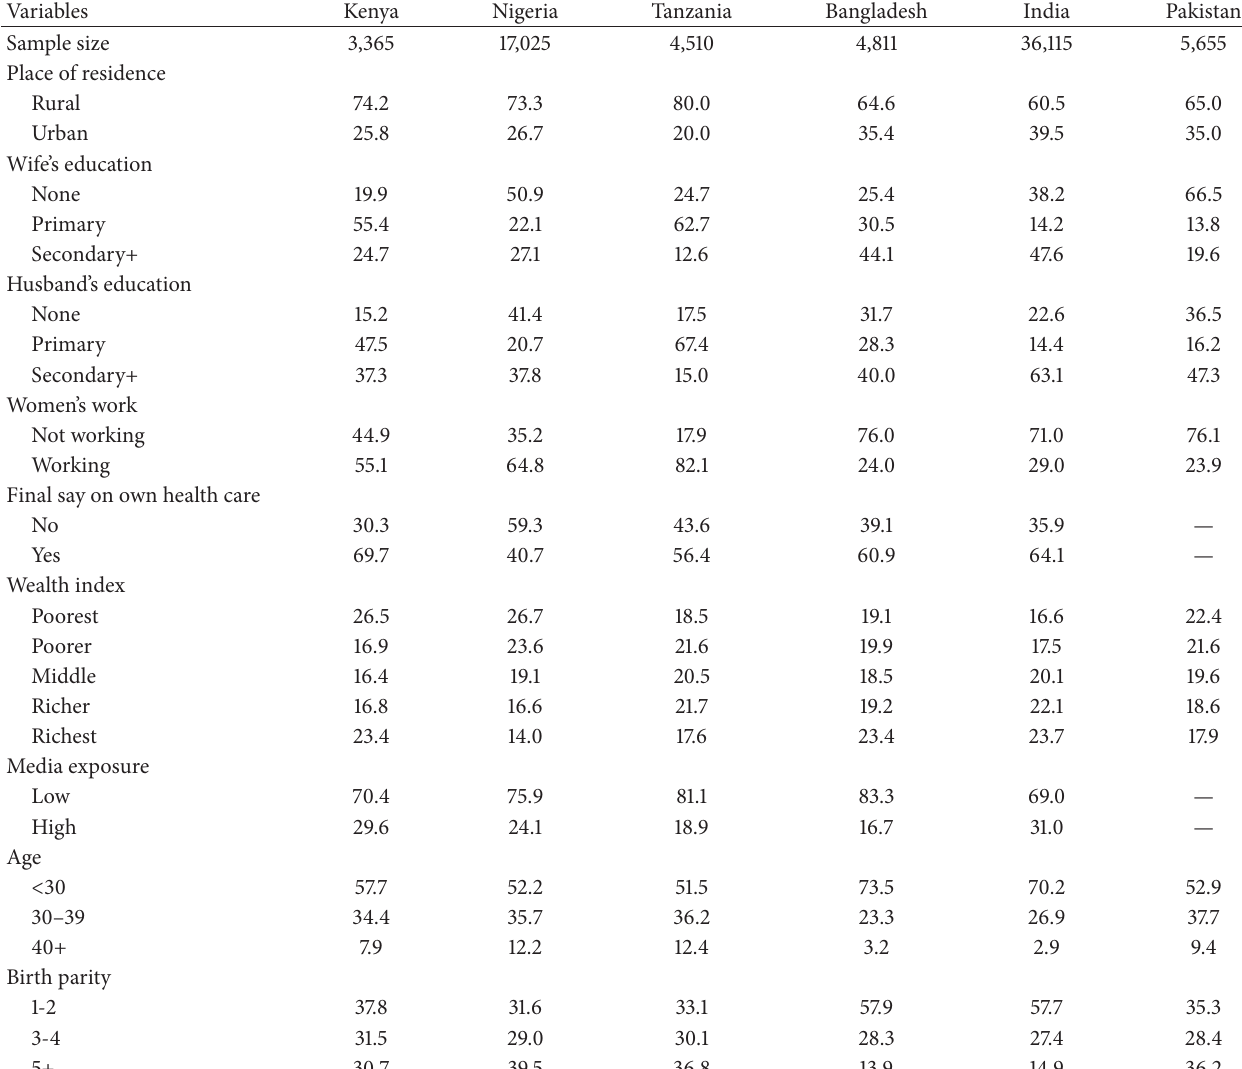
Table 1: Percentage distribution of the study population by